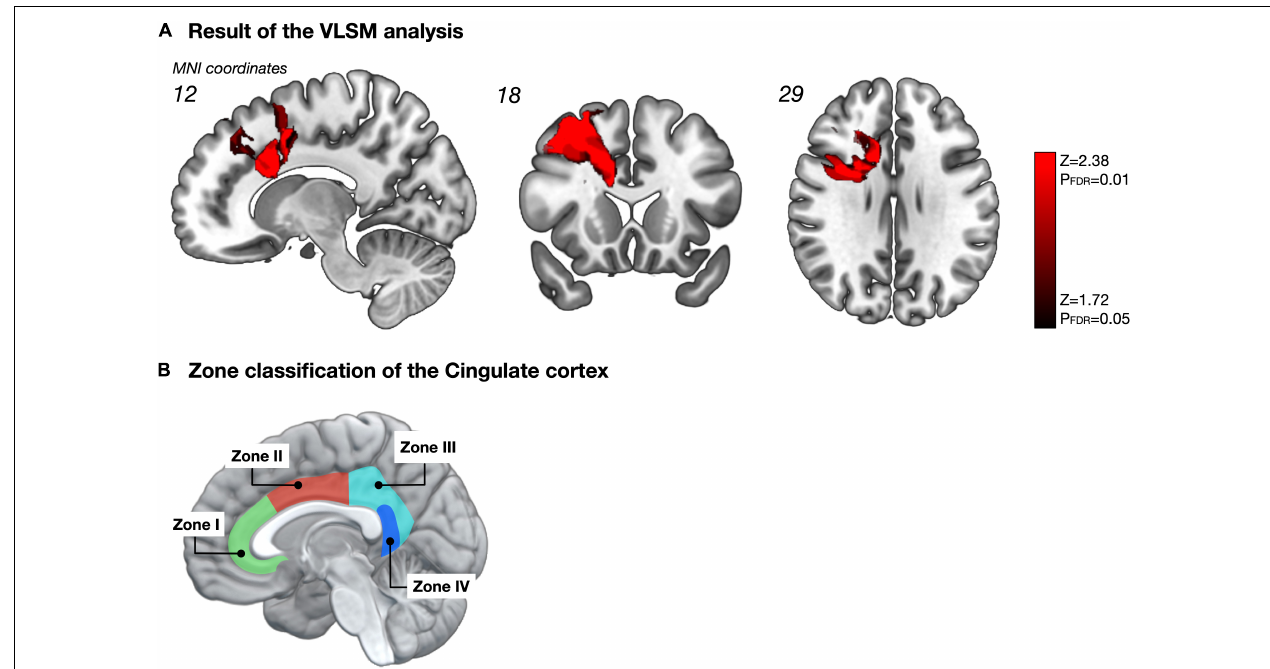
FIGURE 4 | Impact of resected region on selective attention (A) . The statistical map obtained from the voxel-based lesion-symptom mapping (VLSM) shows only significant voxels with a false discovery rate-controlled threshold ( p = 0.05; z = 1.72). Among these significant regions, the cortical area that showed the highest correlation with selective attention was the middle CC, namely zone II of the CC, according to multiple logistic regression analysis with Stepwise method (B) . The figure B was made based on Tate et al. (2011). Permitted by J.